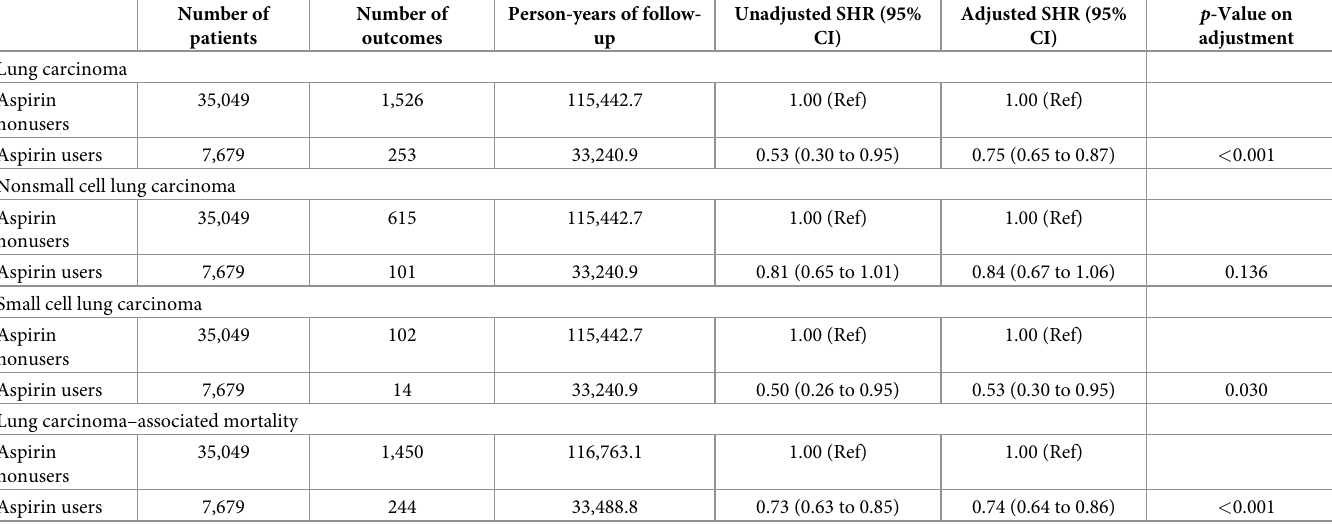
Table 2. Association between aspirin use and lung carcinoma.